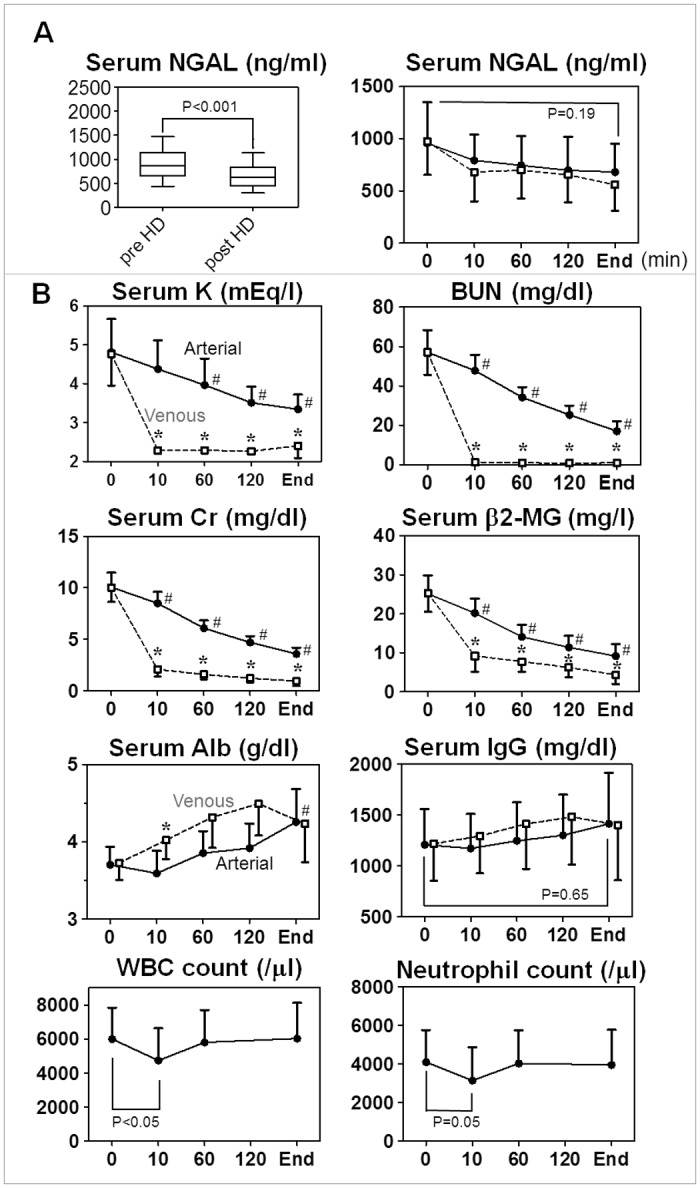
Removal of circulating substances by HD session.Blood was serially drawn from the arterial and venous ends of HD circuit (closed circle and open box, respectively) during HD session. End points varied from 3.0 to 4.5 h. Mean±SD. (A) Comparison of arterial blood NGAL levels between before and after HD session (left, n = 139). Time course of arterial and venous NGAL levels are also shown (right, n = 9). (B) Serum levels of K, BUN, creatinine (Cr), β2-microglobulin (MG), albumin (Alb) and IgG, as well as blood WBC and neutrophil counts are shown (n = 9). Arterial levels of K, BUN, Cr, β2-MG were always higher than venous levels, indicating active removal by HD. On the other hand, venous levels of albumin and IgG tended to be higher than arterial levels, reflecting hemoconcentration by HD. #P<0.05, significant difference from time 0 by repeated-measures ANOVA. *P<0.05, significant difference between arterial and venous blood.